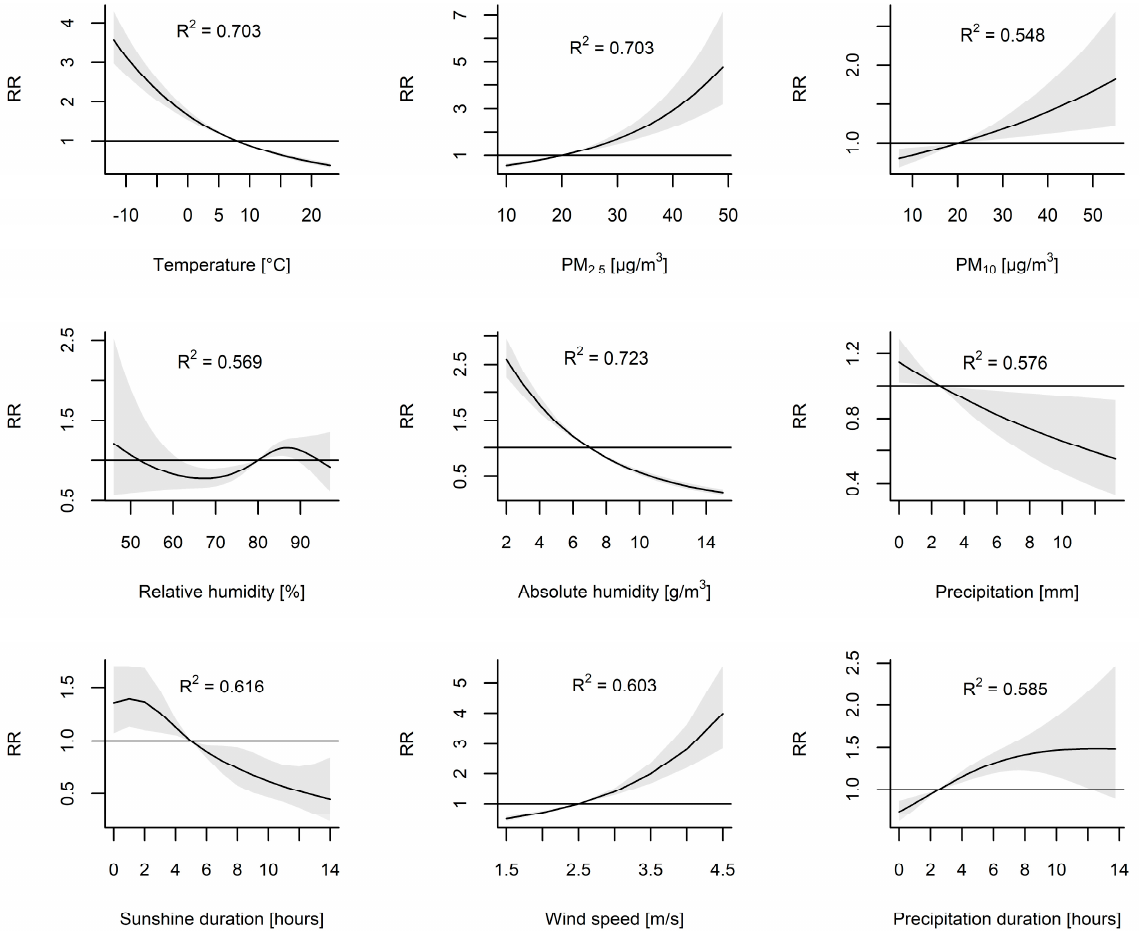
Figure 2. The association between environmental factors and the relative risk (RR) with 95% confidence interval (CI) of influenza-like illness. The models for climatic variables were adjusted for mean concentrations of PM 2.5 and the long-term trend. The models for PM 2.5 and for PM 10 were adjusted for the mean temperature and the long-term trend. The reference levels were defined as the median values of each of the analyzed variables to calculate RRs.